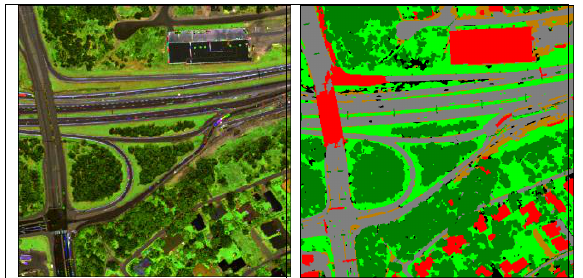
Figure 6. Optech Titan colour coded image (left) and classified image (right).